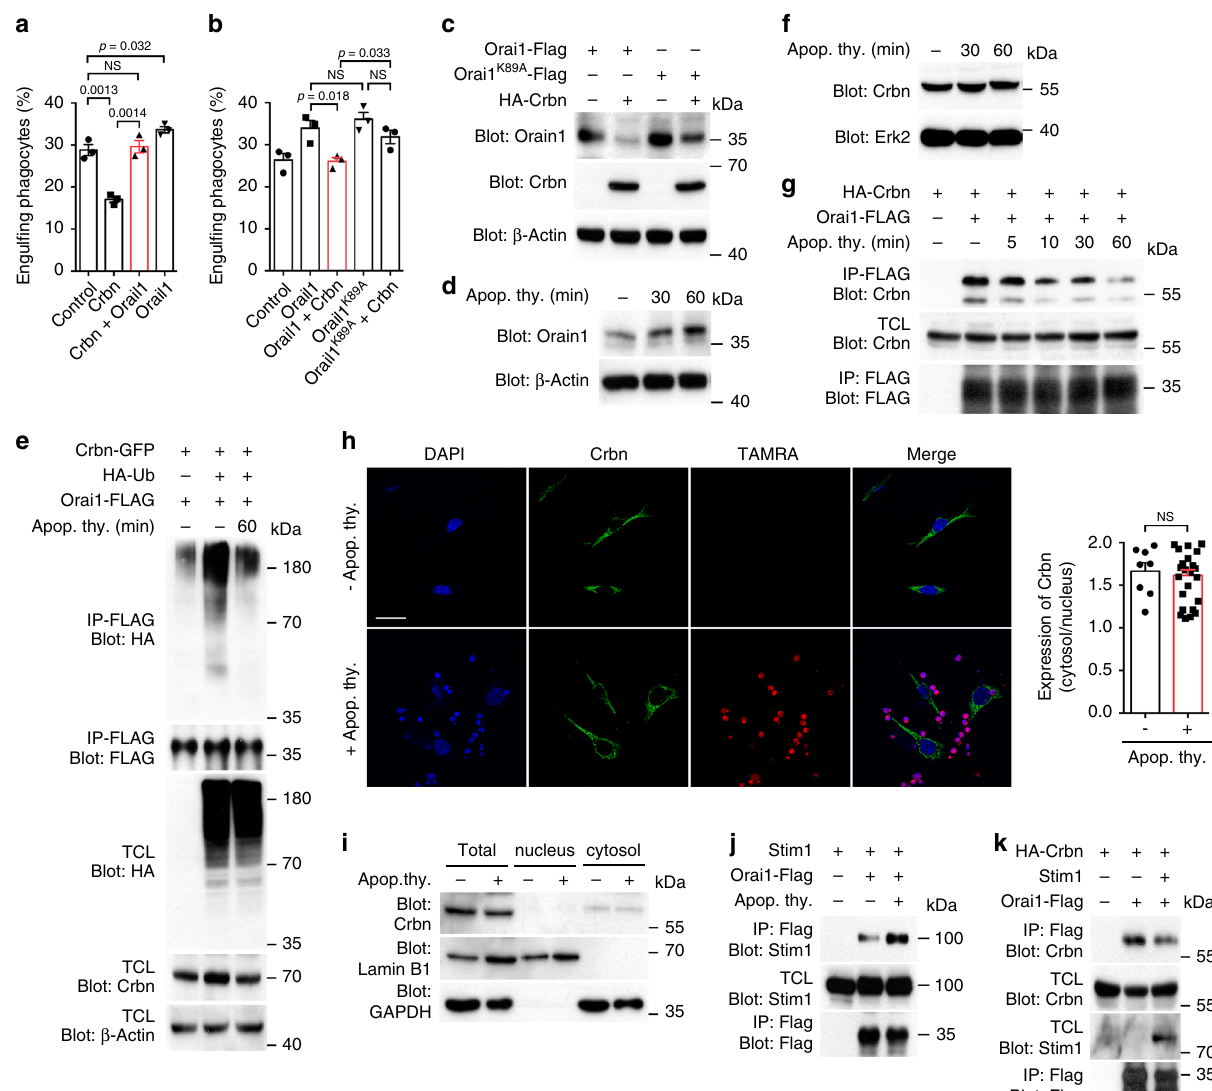
100IP: Flag Blot: Stim1 100TCL Blot: Stim1 35IP: Flag Blot: Flag